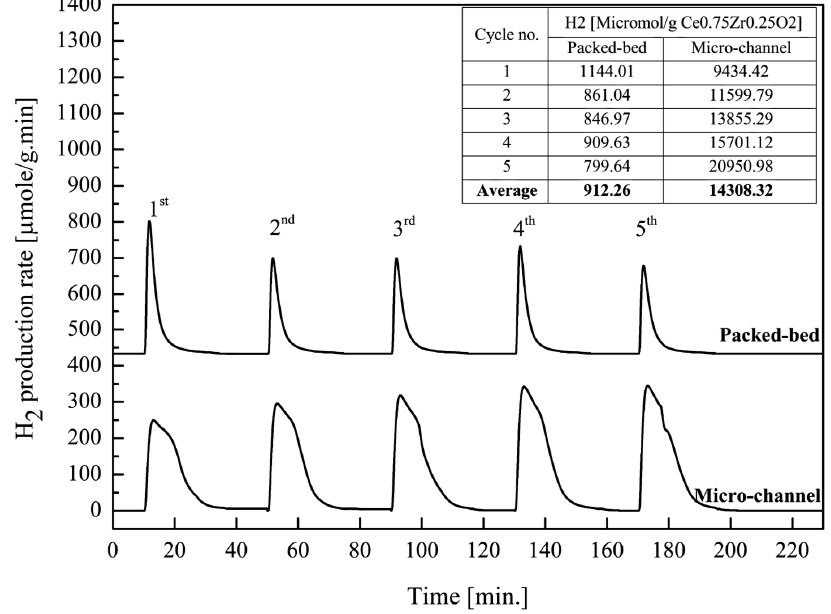
Figure 7. Comparison of H 2 productivity over Ce 0.75 Zr 0.25 O 2 received from the micro-channel reactor and the packed-bed reactor at reduction / oxidation temperature at 700 / 700 °C.